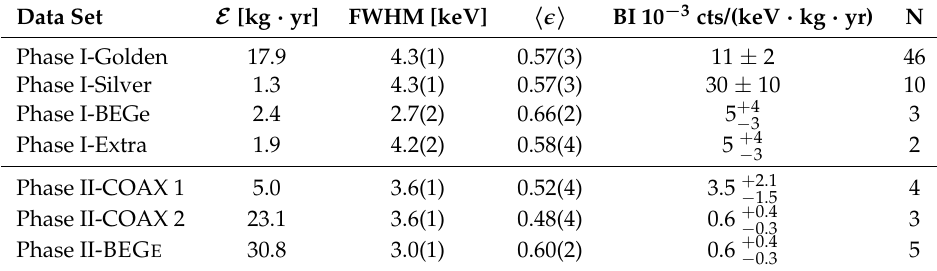
Table 1. Parameters for the six data sets: “N” is the number of events in the 230 keV window centered at Q ββ and BI the respective background index, calculated as N/( E · 230 keV). Data Set